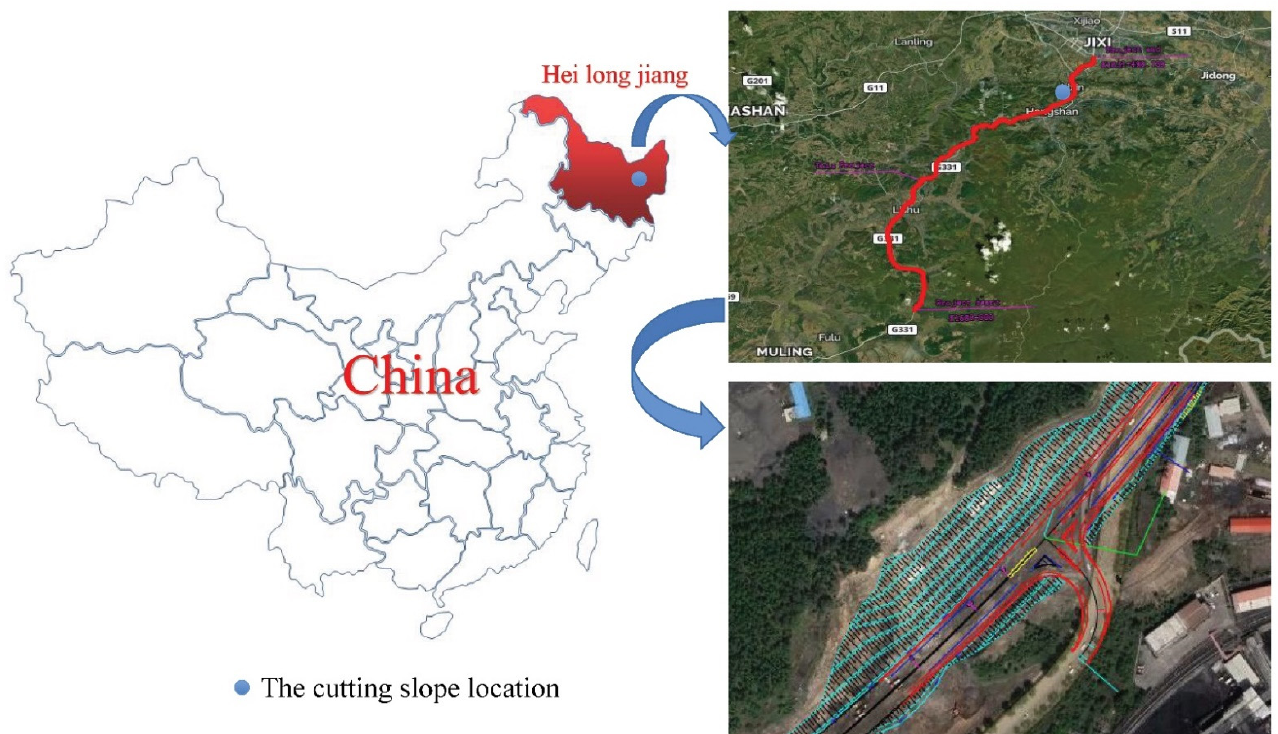
Figure 1. Project location and overall map of the cutting slope.